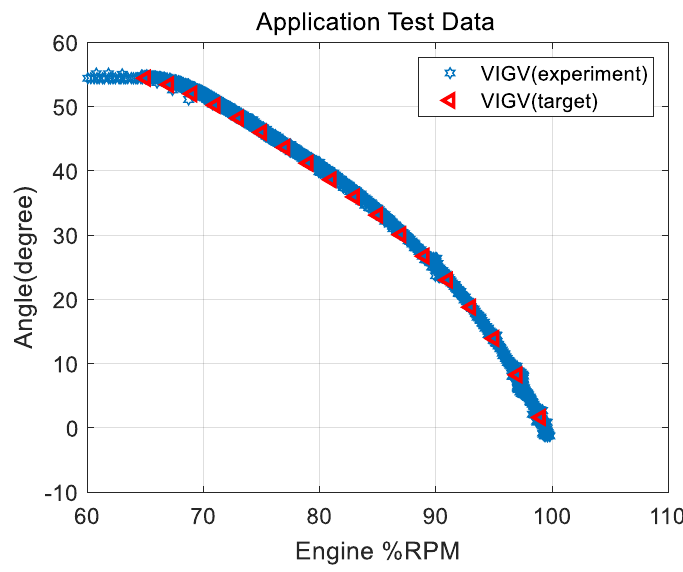
Figure 13. Mechanical hysteresis of link mechanism.